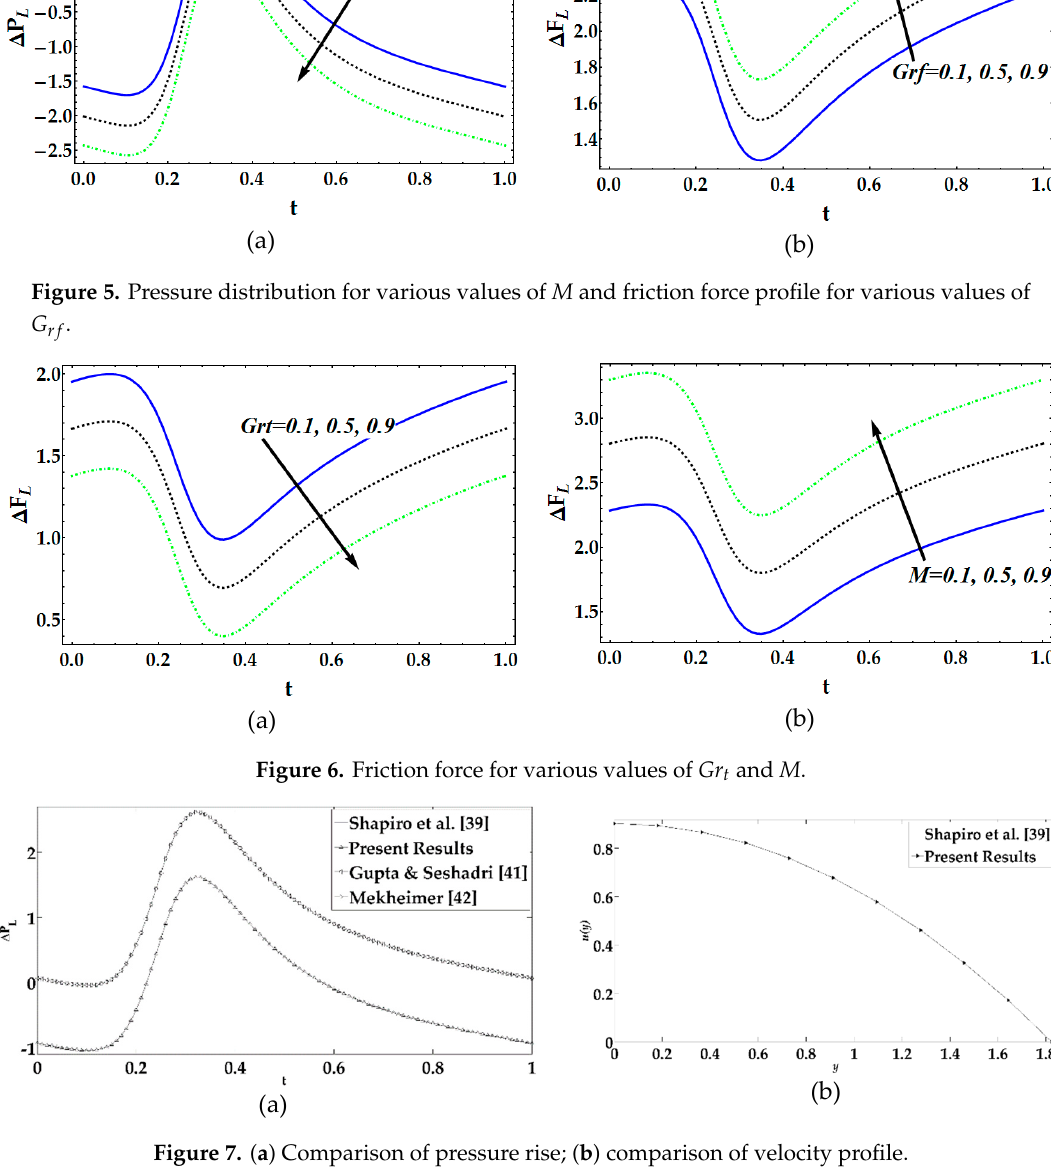
Figure 7. ( a ) Comparison of pressure rise; ( b ) comparison of velocity profile.